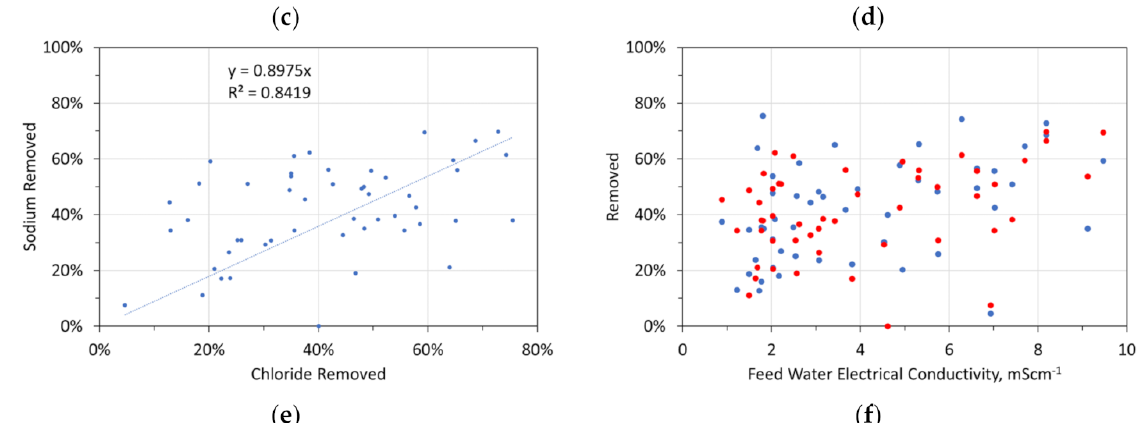
Figure A2. Ion removal. ( a ), Feed water chloride ion concentration versus product water chloride ion concentration; ( b ), Feed water sodium ion concentration versus product water sodium ion concentration; ( c ), Feed water salinity versus proportion of chloride ions in the feed water removed; ( d ), Feed water salinity versus proportion of sodium ions in the feed water removed; ( e ), Proportion of chloride ions in the feed water removed versus proportion of sodium ions in the feed water removed; ( f ), Feed water electrical conductivity versus the proportion of ions removed from the product water; Blue dots = chloride ions; red dots = sodium ions.